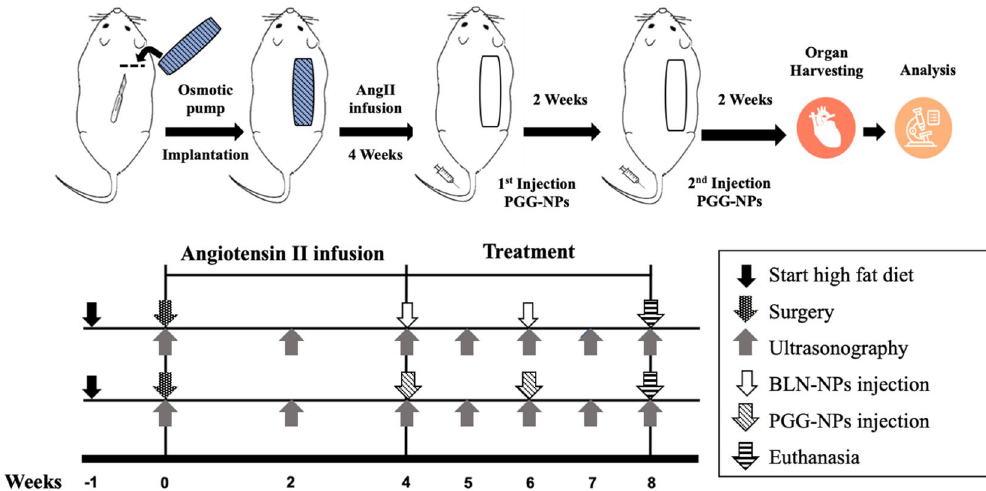
Figure 1. Schematic representation of the study design (created in